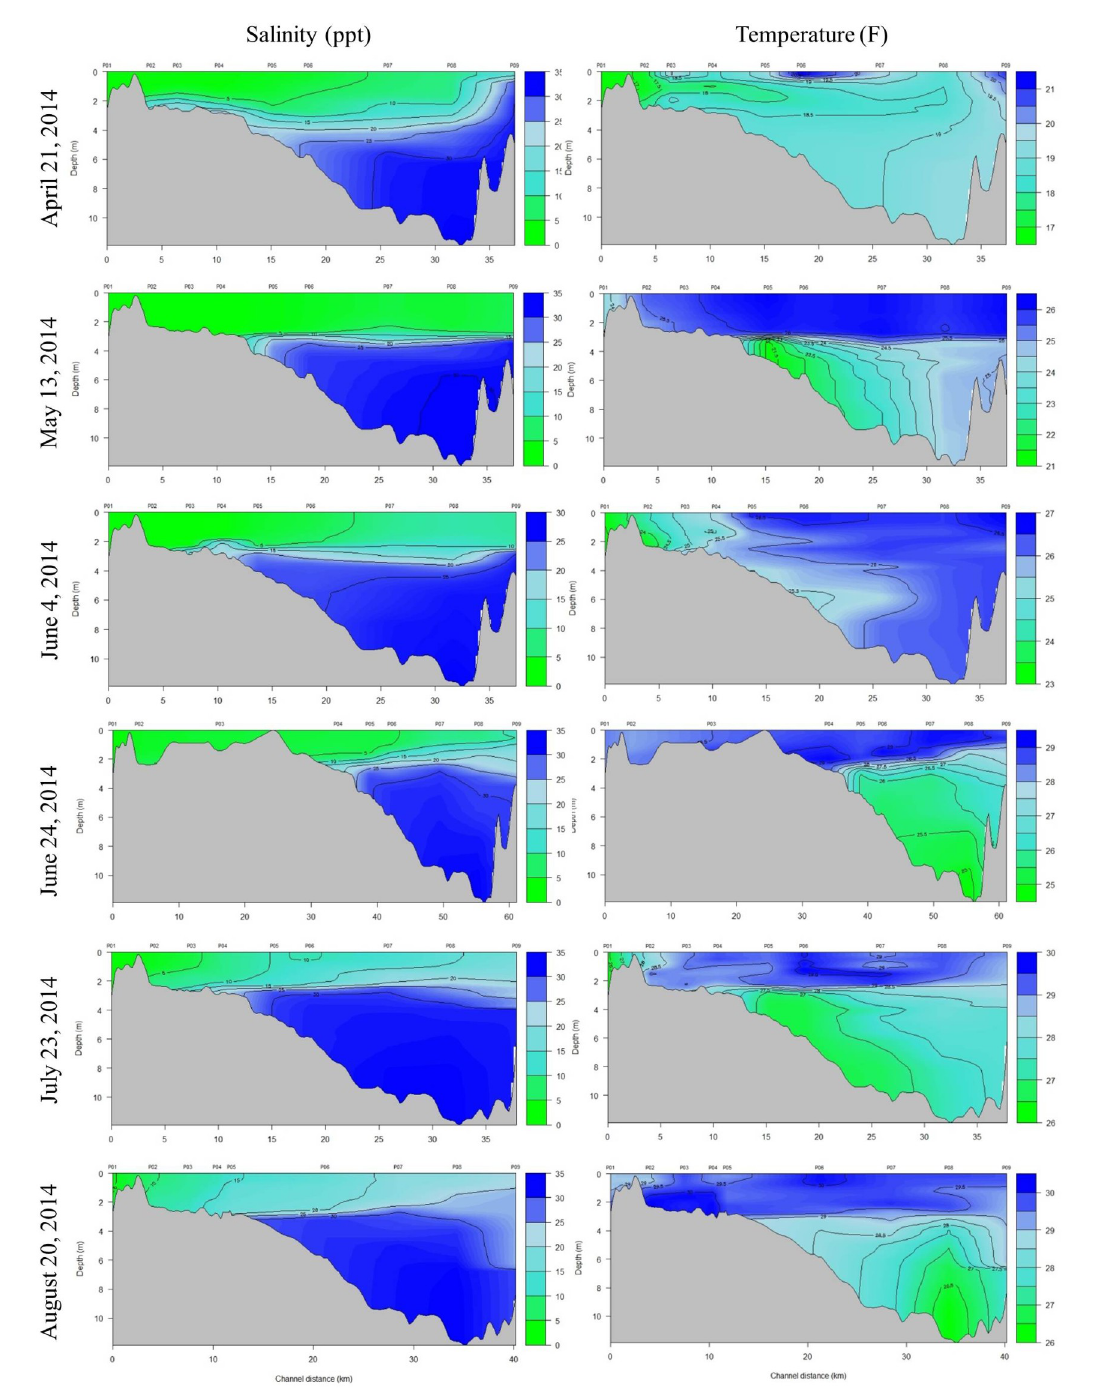
Fig 5. Salinity-depth profiles from EPA CTD stations along a transect that runs through the Escambia-Pensacola Bay system (see Fig 2) for April–August 2014. Station numbers are listed across the top (P01-P09) where P01 is located at the mouth of the Escambia River and P09 is at the mouth of Pensacola Pass. Escambia Bay opens into Pensacola Bay roughly at station P05; Channel distance is the distance from station P01.